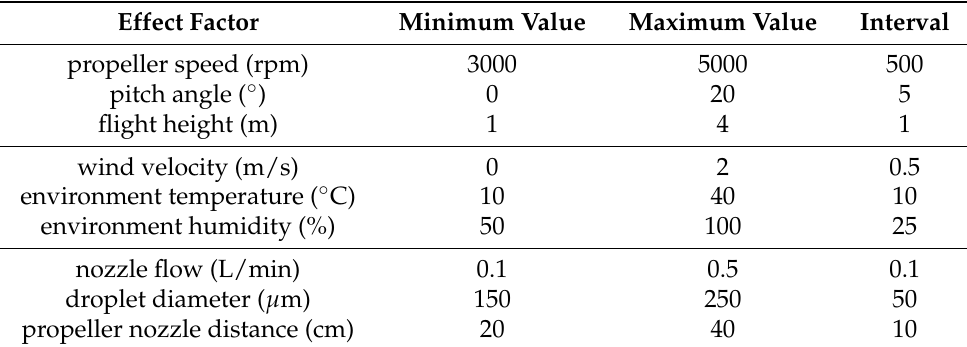
Table 3. Variation range of nine factors in orthogonal